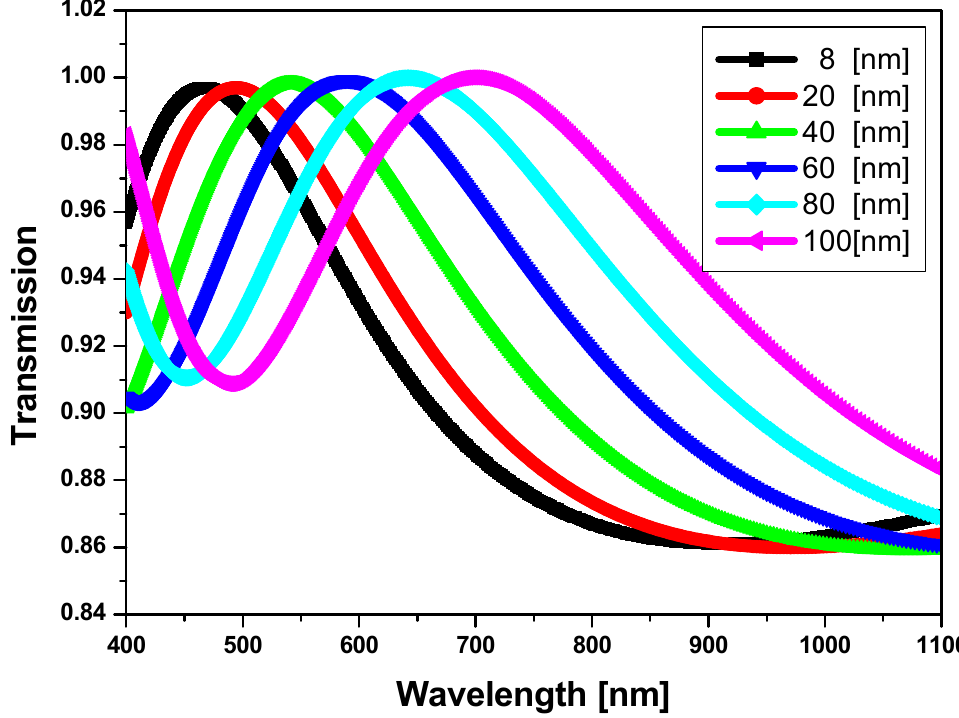
Figure 4. Transmission behavior of the structure with different thicknesses of the third layer of dielectric ARC and thicknesses of 98 nm, 45 nm for the first and second layer, respectively.